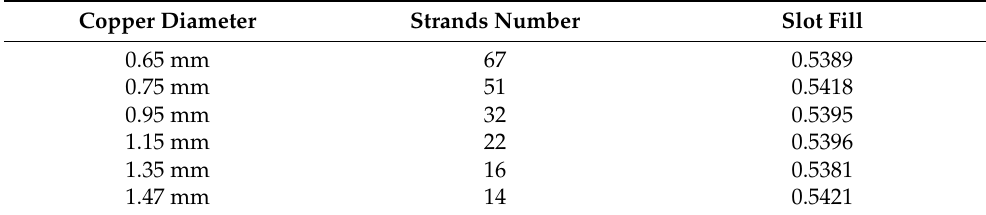
Figure 10. Current density distribution with different conductor diameters at 1000 Hz for Case B. Table 2. Windings data in different cases.